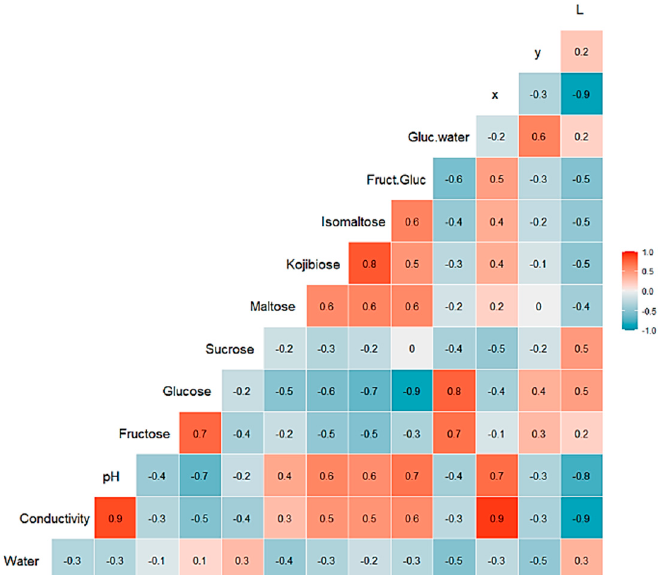
Figure 1. Correlation chart among the 14 predictor variables for the whole dataset. The number in each square is rounded to one figure. The color scale at the right indicates color meaning. Red color means positive correlation; blue color means negative correlation.